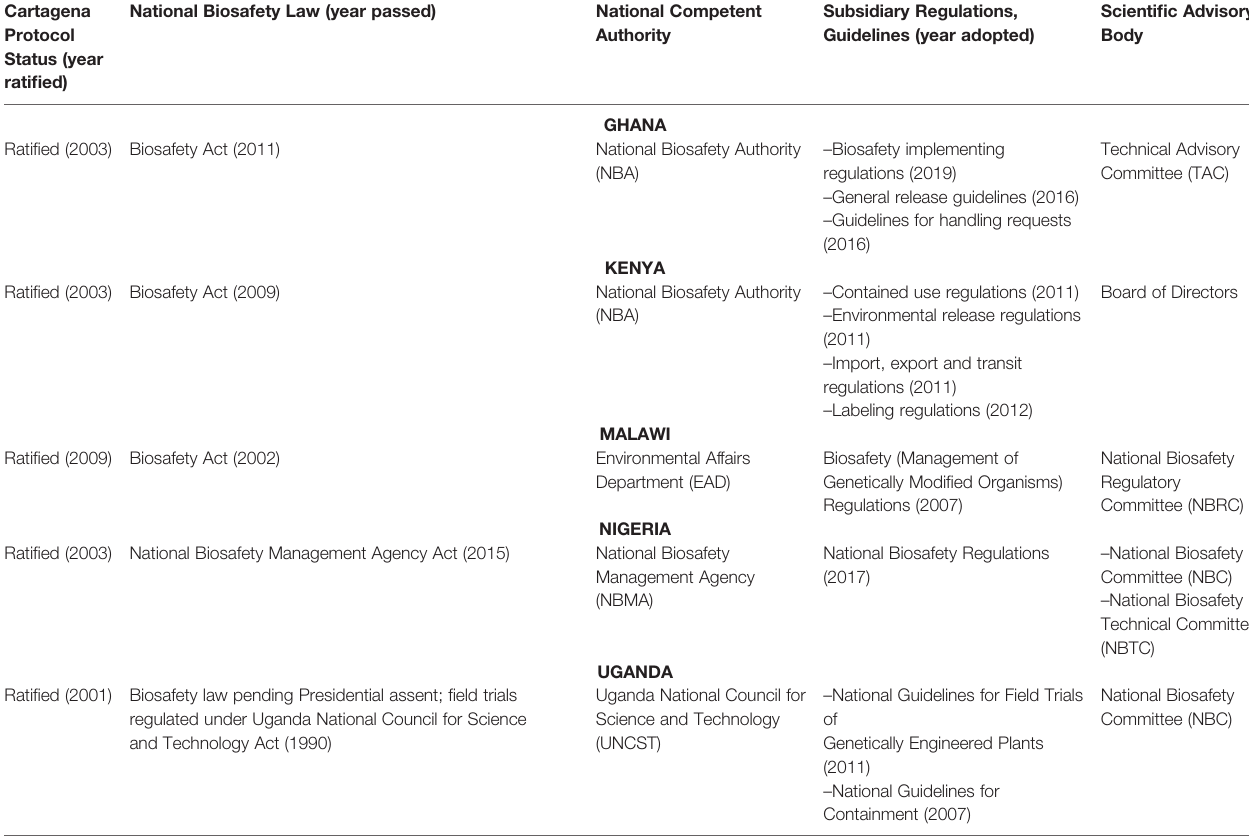
TABLE 2 | Biosafety regulatory frameworks in Ghana, Kenya, Malawi, Nigeria and Uganda (2019). Cartagena